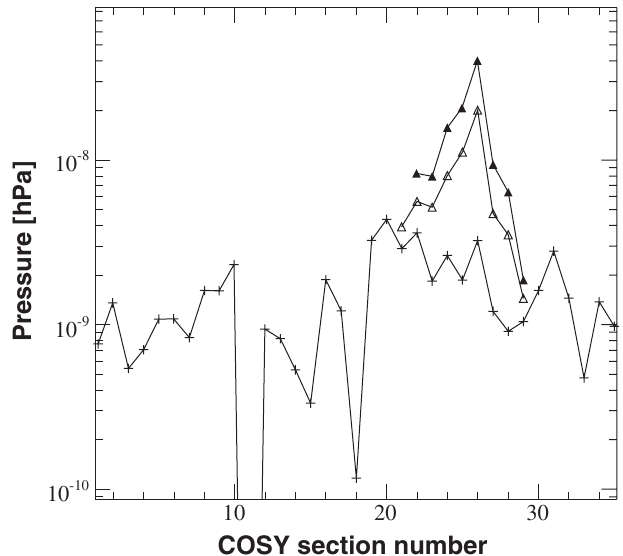
FIG. 7. Vacuum pressure profile along sections of the COSY ring; ANKE is placed close to section number 26. Crosses show the pressure profile for the situation when the (cluster-jet) target beam is off, the increase illustrated by the open triangles is due to the target-on effect, and the closed triangles that when the COSY beam is allowed to interact with the target jet. The lines are drawn to guide the